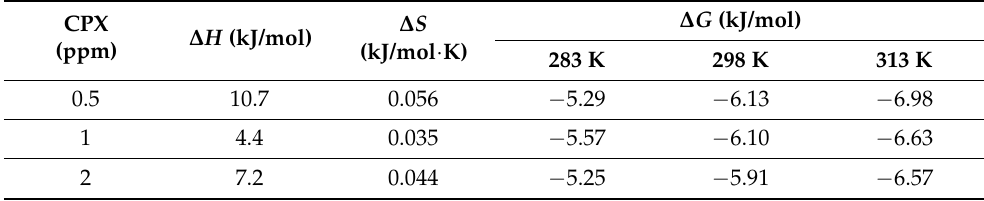
Figure 5. Ciprofloxacin adsorption onto GO/Ca-Alg 2 –PAM beads depending on temperature. Table 3. The thermodynamic parameters of ciprofloxacin adsorption on to GO/Ca-Alg 2